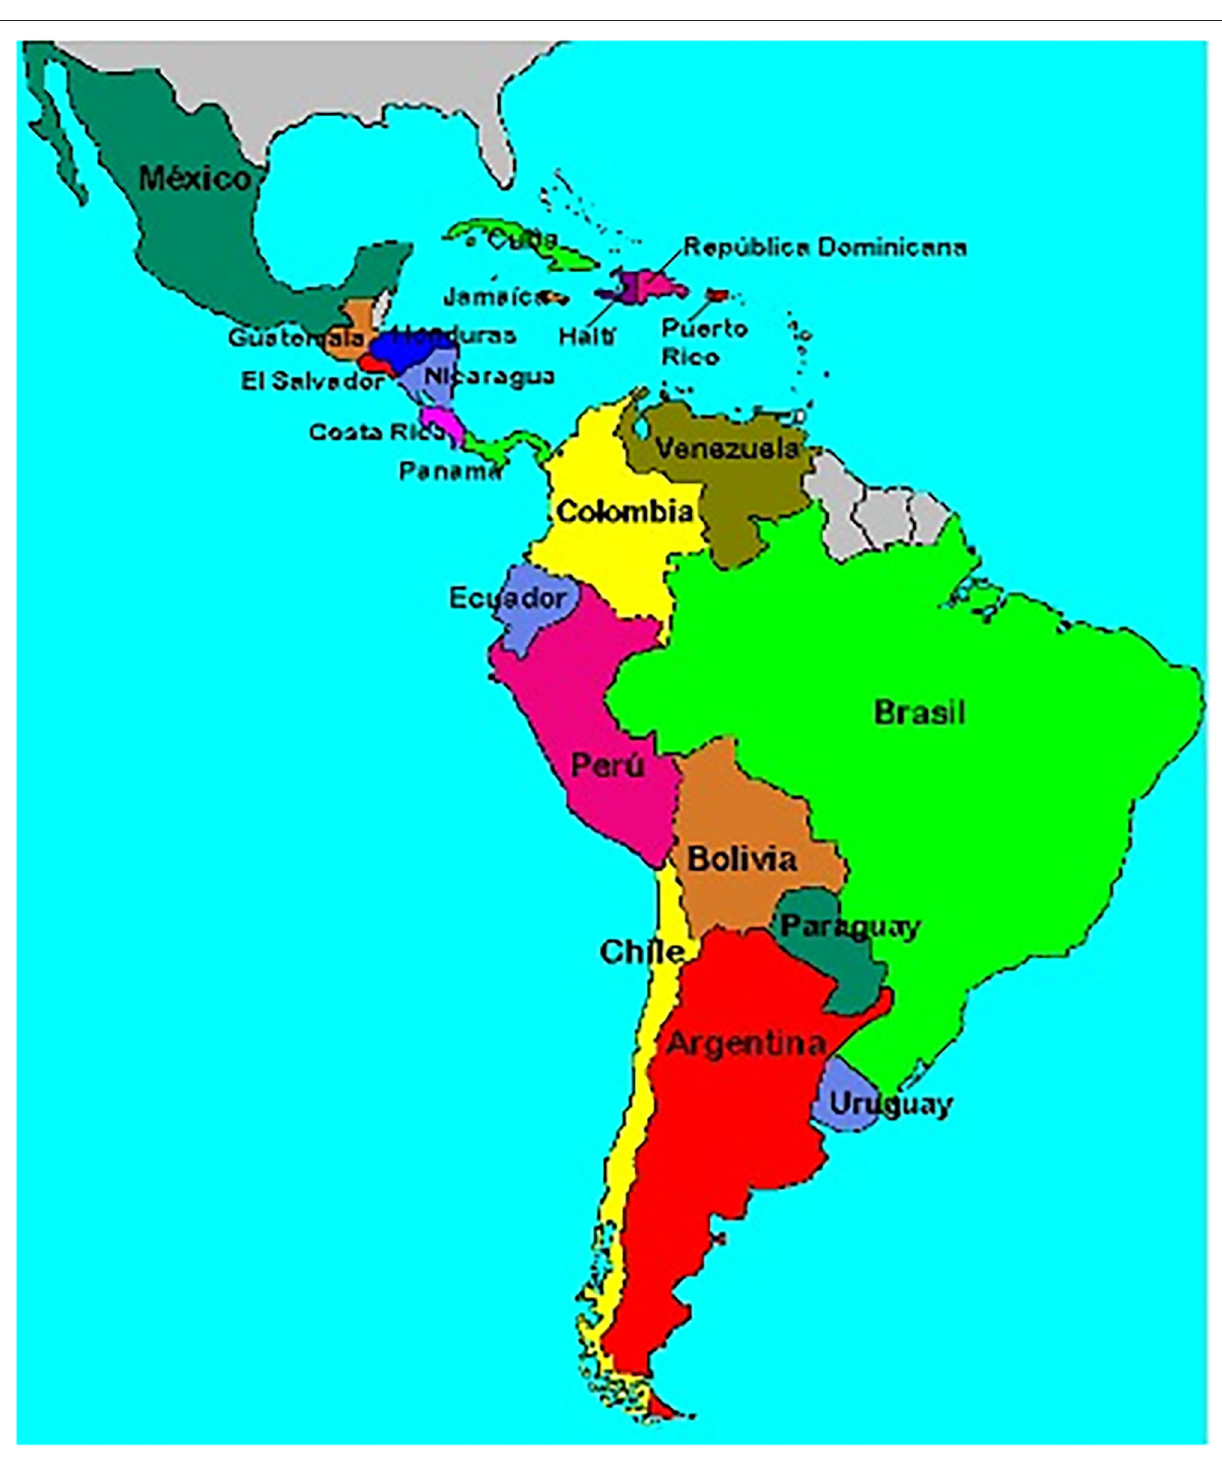
FIGURE 1 | Map showing Latin American